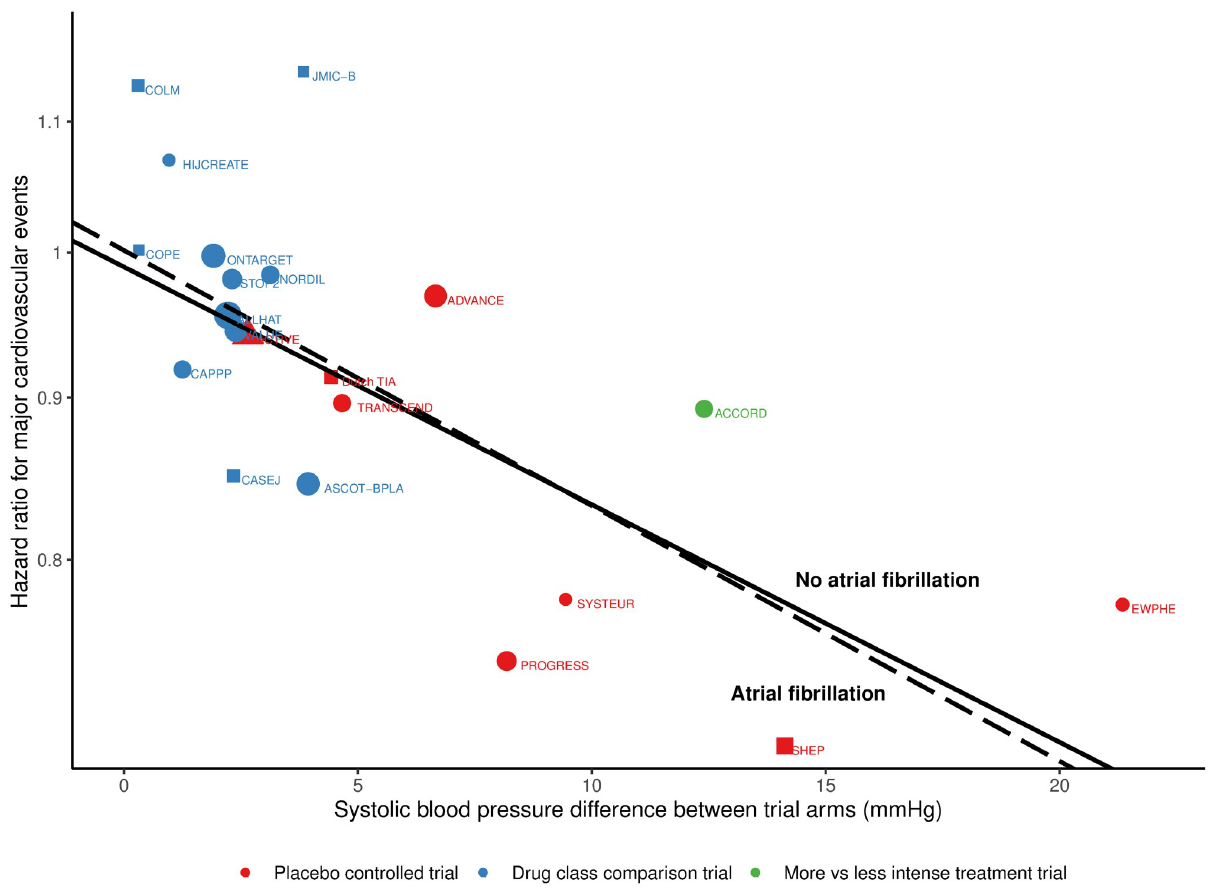
Fig 2. Hazard ratio of major cardiovascular events related to the 1-year difference blood pressure reduction aggregated at trial level. Risk of major cardiovascular events, for patients with (dashed line) and without (solid line) atrial fibrillation at baseline, regressed against the systolic blood pressure difference between trial arms, plotted on the log scale. Shapes represent the hazard ratio for each trial with the size inversely proportional to the respective standard error. Trials are coded by shape according to the type of patients: atrial fibrillation only (triangle), no atrial fibrillation only (square), and mix of both (circles). Trials are also coded by colour according to type of intervention: placebo-controlled trials (red), drug class comparison trials (blue), and more versus less intense treatment trials (green). Systolic blood pressure difference between trial arms in mm Hg.